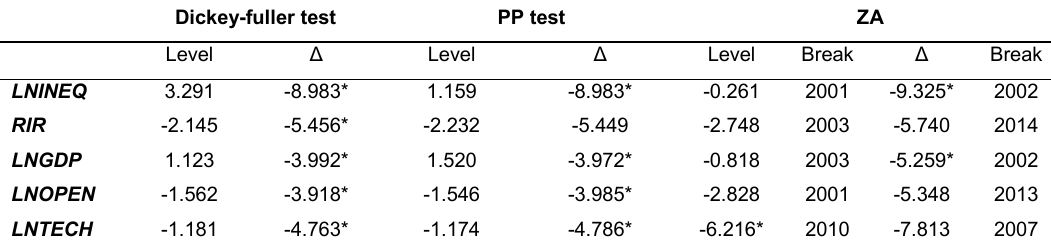
Table 3. Unit root